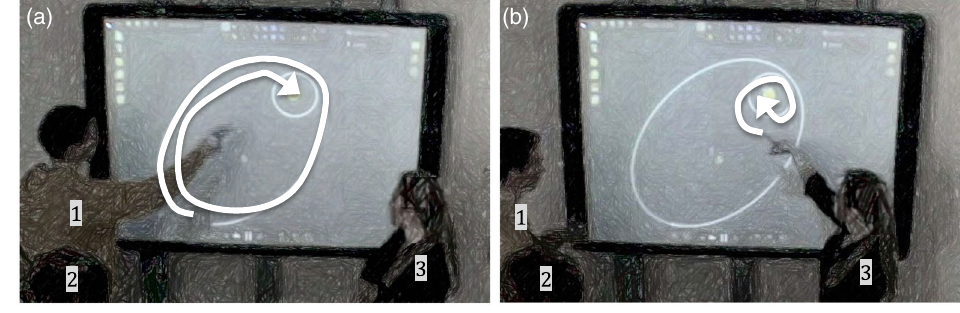
FIG. 8. In the sequence shown in the figure, we can see a symbiotic gesture, produced by student 1 and its immediate repetition by student 3. The gestures were produced in a rather quick manner, as rough illustrations of the type of motion that students 1 and 3 expected to see after they introduce air resistance into the simulation. The students did not move their hands in the plane of the IWB surface, but rather used their index finger to point to an imaginary point on the IWB surface, and in this way extended the effective spatial reach of their gestures. The arrow represents the position of the imaginary point of intersection between the direction of their pointing and the plane of the IWB screen.